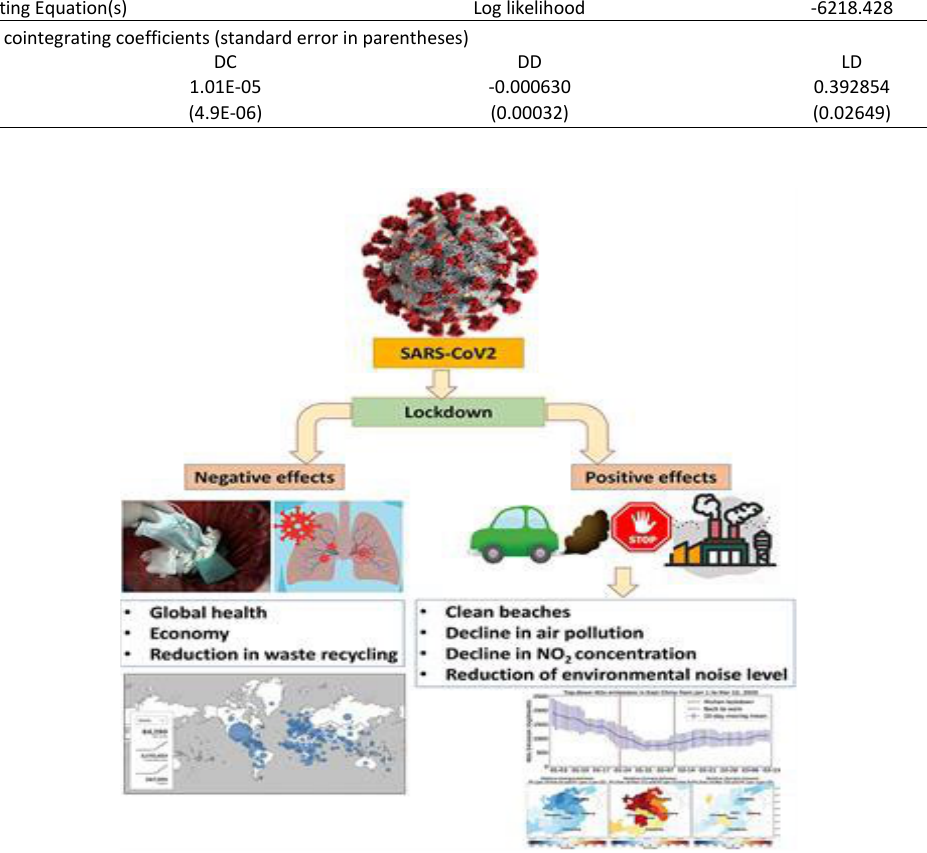
Fig. 3: COVID-19, lockdown and the effects on the world